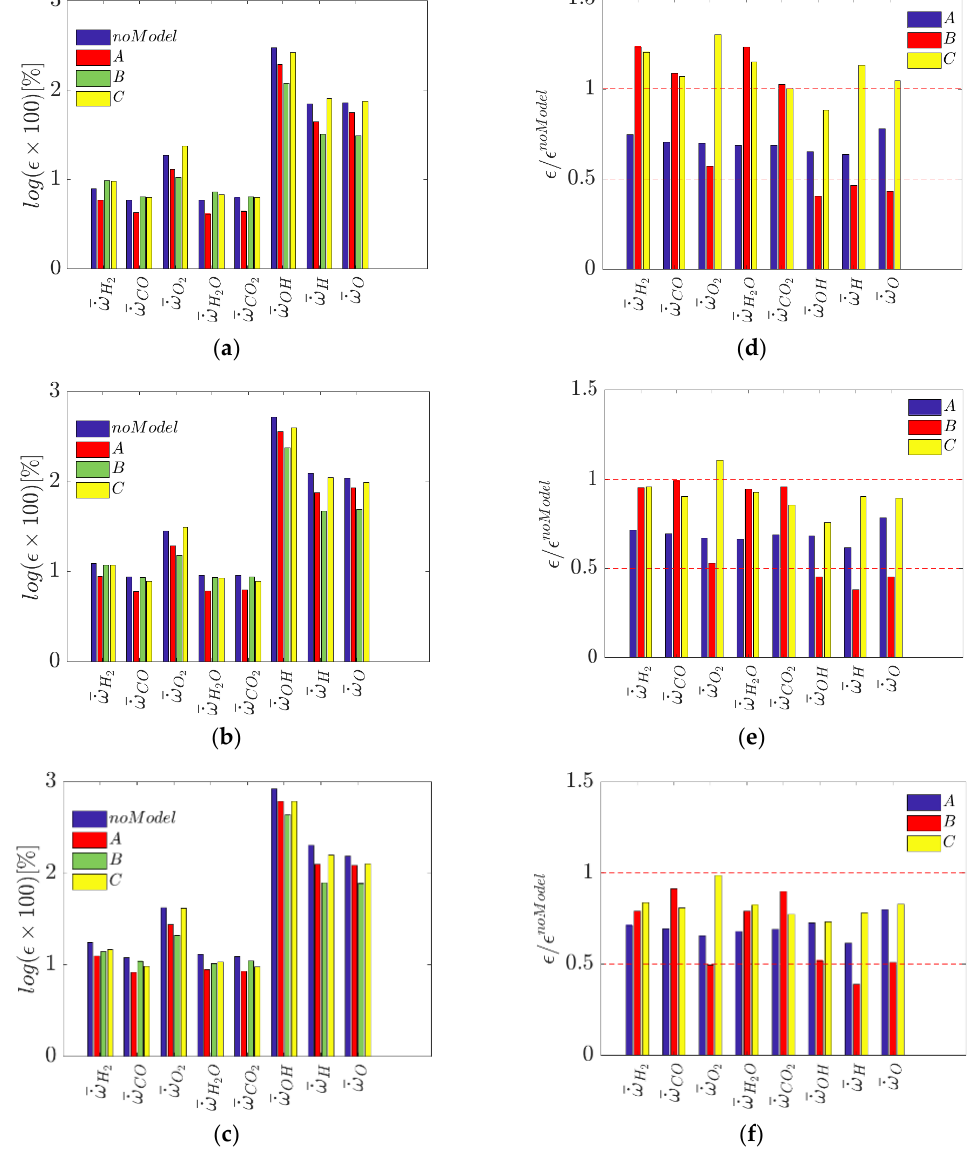
Figure 5. Cumulative local errors incurred using different models in prediction of different species net formation rates: ( a , b , c ) logarithm of errors for all models; and ( d , e , f ) the errors divided by the “no model” approach error. Different filter widths are applied: ( a , d ) ∆/∆ DNS = 8; ( b , e ) ∆/∆ DNS = 12; and ( c , f ) ∆/∆ DNS = 18. The data are extracted at 𝑡 = 20𝑡 𝑗 .